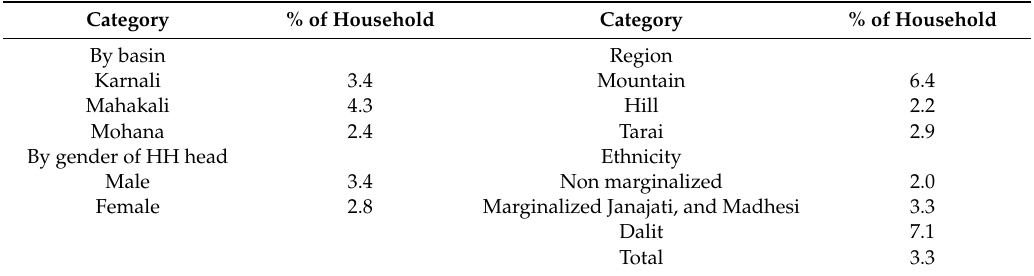
Table 5. Percentage of households who received any sort of assistance to dealing with the